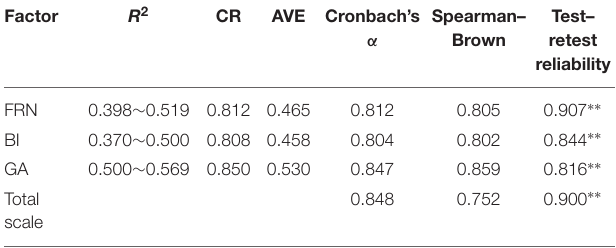
TABLE 7 | Correlations of TDFPS with DFPS and CFPS ( n =